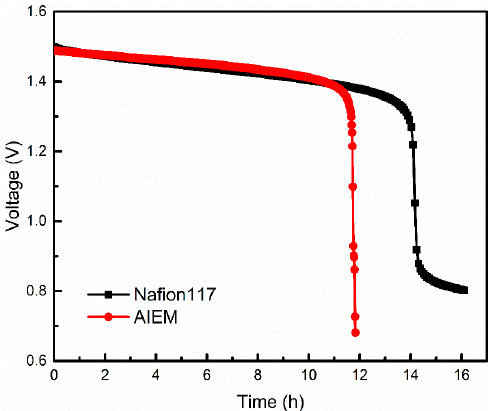
Figure 8. Open circuit voltage of the VRFB assembled with Nafion117 membrane and AIEM (GY =